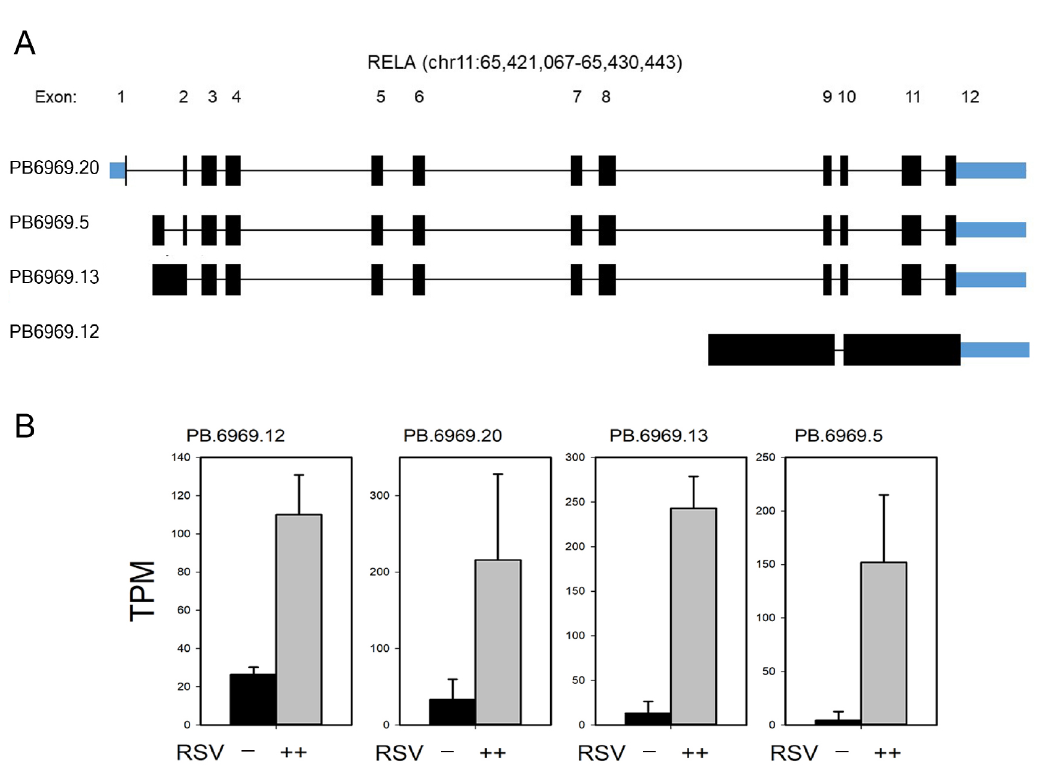
Figure 8. Annotation and expression of NF κ B/RelA AS forms. ( A ) Transcript annotation for NF κ B/RelA. Exons are numbered at the top, relative to the RefSeq annotation; genomic coordinates are indicated. Coding exons are indicated in black; noncoding exons are indicated in blue. PacBio sequence identifiers are at the left. PB6969.5 is a novel tran- script. ( B ) Quantitation of the most abundant RelA transcripts from short-read RNA sequencing. Data are presented